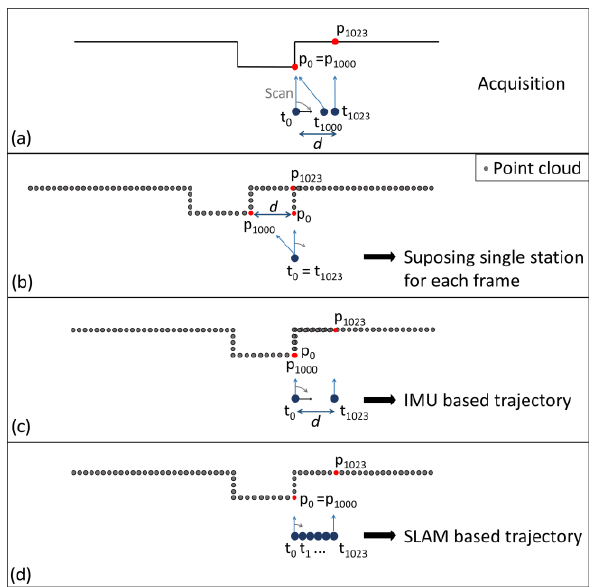
Figure 1. (a) Simulation of a mobile acquisition using an Ouster laser scanner system with 1024 rotational steps and a horizontal FoV of 360° and the estimated sensor position as (b) discrete points considering 360° laser frames, (c) discrete points with the correction of the 360° laser frames, and (d) as continuous